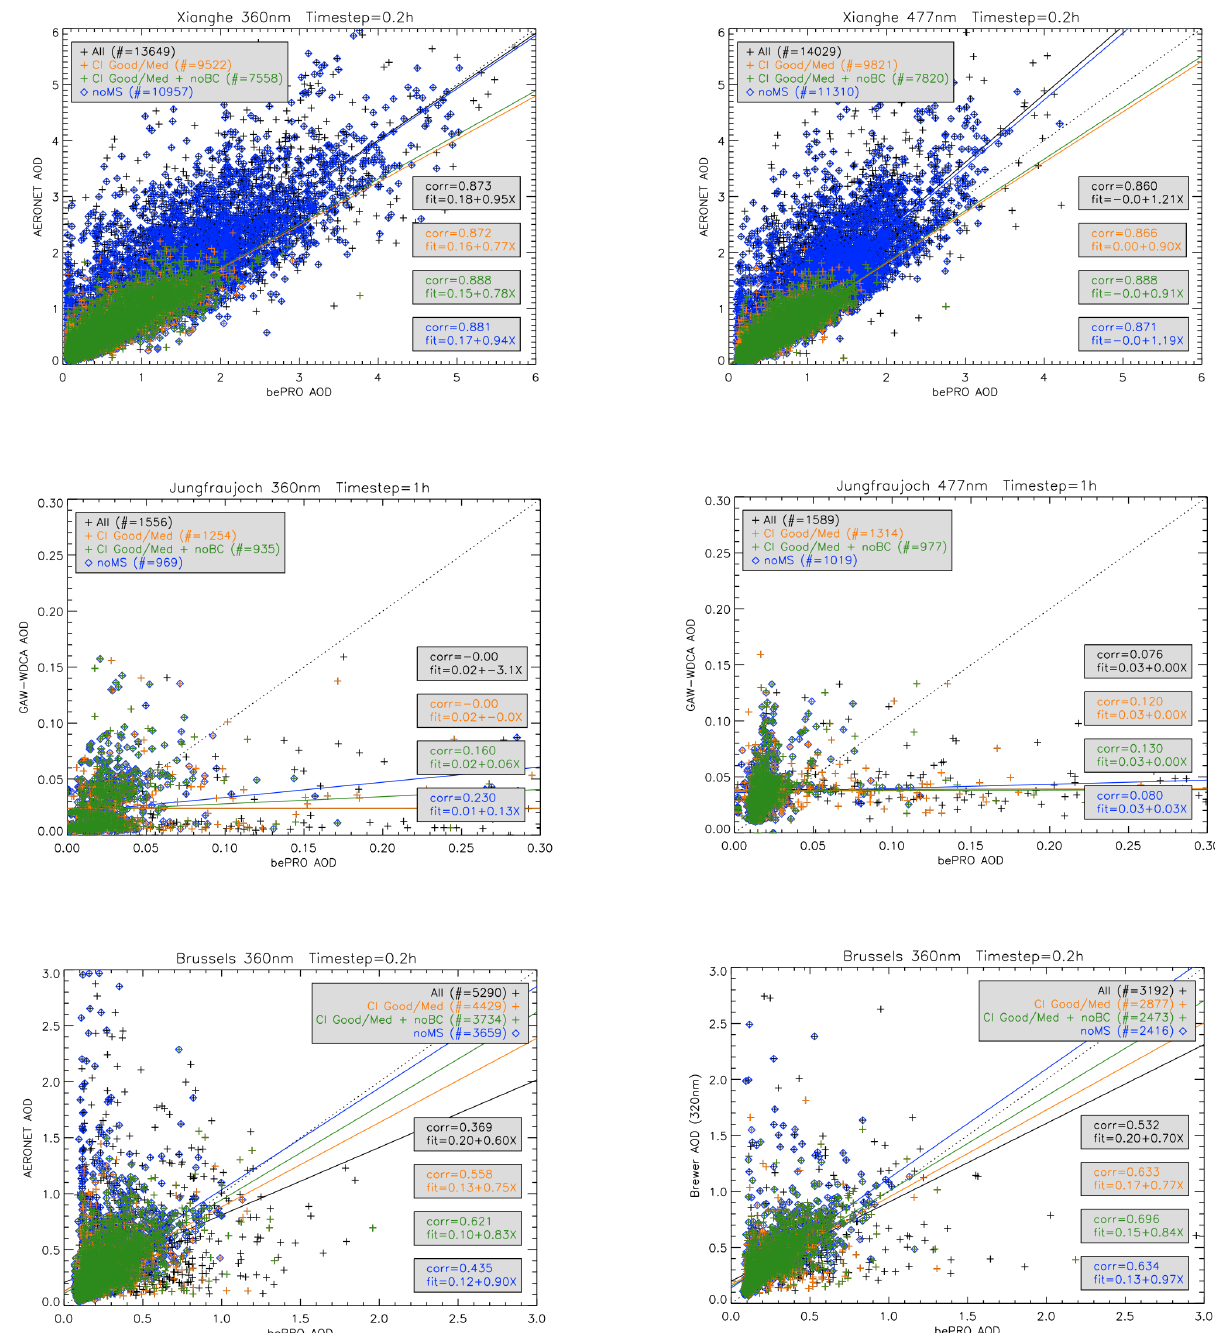
Figure 14. Correlation plots of our bePRO MAX-DOAS AOD retrievals and measured AOD values for the Xianghe and Jungfraujoch data set at 360 and 477nm and for the Brussels at 360nm, in time steps of 0.2h. for Xianghe and Brussels and 1h for Xianghe. The full non- cloud-screening data is given by black crosses. Cloud-screened data (based on the CI) with a “good/mediocre” sky flag are marked in orange, data with “good/mediocre” sky flag and no broken-cloud flag are marked in green crosses. Data with no multiple-scattering flag (based on the O 4 DSCDs) are marked with blue diamonds. For each sample set we also give the linear regression lines and correlation